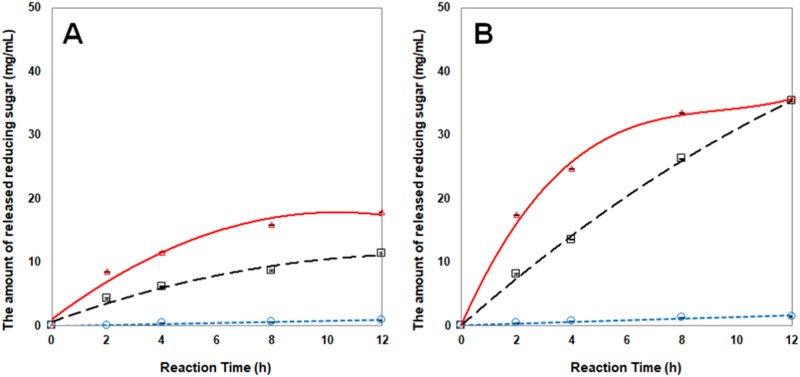
Biocatalytic hydrolysis pattern of normal corn starch granules treated with different amylolytic enzymes at 30°C (A) and 40°C (B).Solid line, α-amylase; short-dashed line, β-amylase; long-dashed line, glucoamylase.